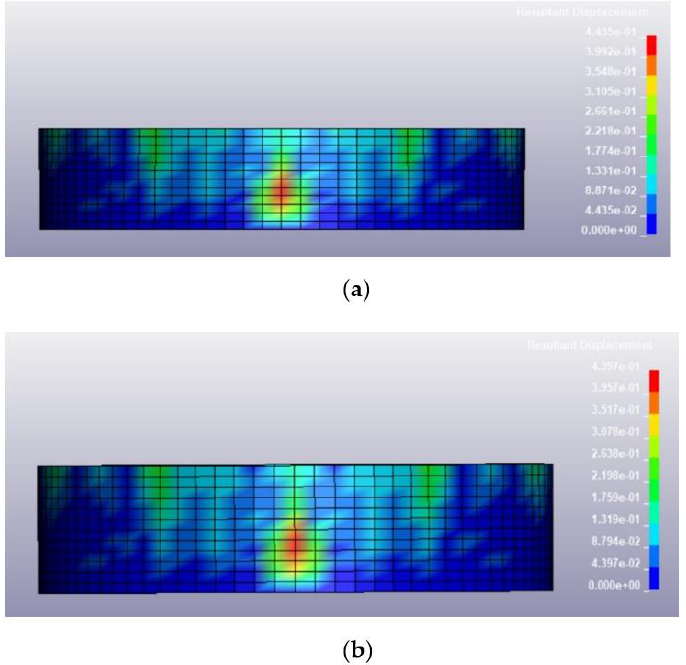
Figure 9. Deformed shape of the tank under blast intensity of 1500 kg TNT equivalent mass 12.5 m away, ( a ) 100% fill level and ( b ) 0% fill level.